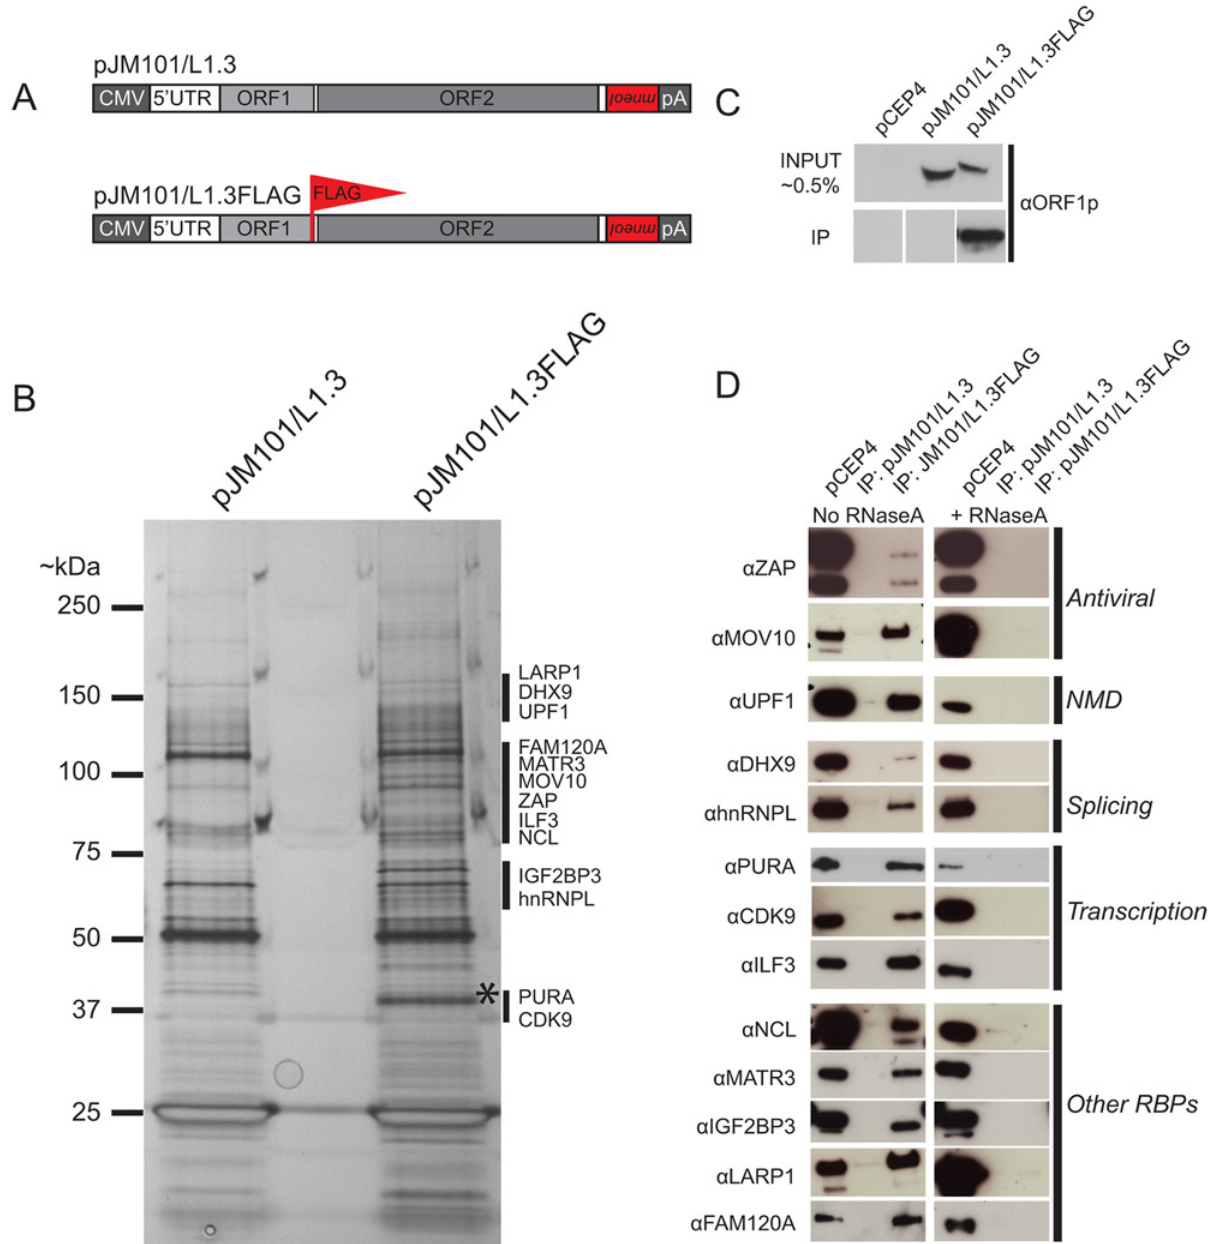
Fig 1. The identification of host proteins immunoprecipitated with L1 ORF1p-FLAG. (A) Schematic of L1 constructs : pJM101/L1.3 expresses a human L1 (L1.3) [5] containing an mneoI retrotransposition indicator cassette within the L1 3' UTR. The pJM101/L1.3FLAG construct is identical to pJM101/L1.3, but contains a single FLAG epitope on the carboxyl-terminus of ORF1p. Both constructs were cloned into a pCEP4 mammalian expression vector. A CMV promoter augments L1 expression and an SV40 polyadenylation signal (pA) is located downstream of the native L1 polyadenylation signal. (B) Results of immunoprecipitation experiments : Whole cell lysates from HeLa cells transfected with either pJM101/L1.3 or pJM101/L1.3FLAG were subjected to immunoprecipitation using an anti-FLAG antibody. The proteins then were separated by SDS-PAGE, visualized by silver staining, and subjected to LC-MS/ MS. An ~40 kDa band corresponding to the theoretical molecular weight of ORF1p is visible in the pJM101/L1.3FLAG lane ( * ). Black bars indicate the approximate molecular weights of the ORF1p-FLAG interacting proteins. Molecular weight standards (kDa) are shown on the left hand side of the gel. (C) Validation of the ORF1p-FLAG immunoprecipitation : Western blot experiments using an antibody specific to amino acids 31 – 49 of L1.3 ORF1p verified the enrichment of ORF1p-FLAG in pJM101/L1.3FLAG, but not pJM101/L1.3 immunoprecipitation reactions. Cells transfected with the pCEP4 vector served as a negative control. (D) Validation of putative ORF1p-FLAG interacting proteins : Western blot images of the pJM101/L1.3FLAG and pJM101/L1.3 immunoprecipitation (IP) reactions. The pCEP4 lanes denote whole cell lysates derived from HeLa cells transfected with an empty pCEP4 vector (~ 1.0% input). Primary antibodies used to probe western blots are indicated to the left of the images. Immunoprecipitation reactions were conducted in either